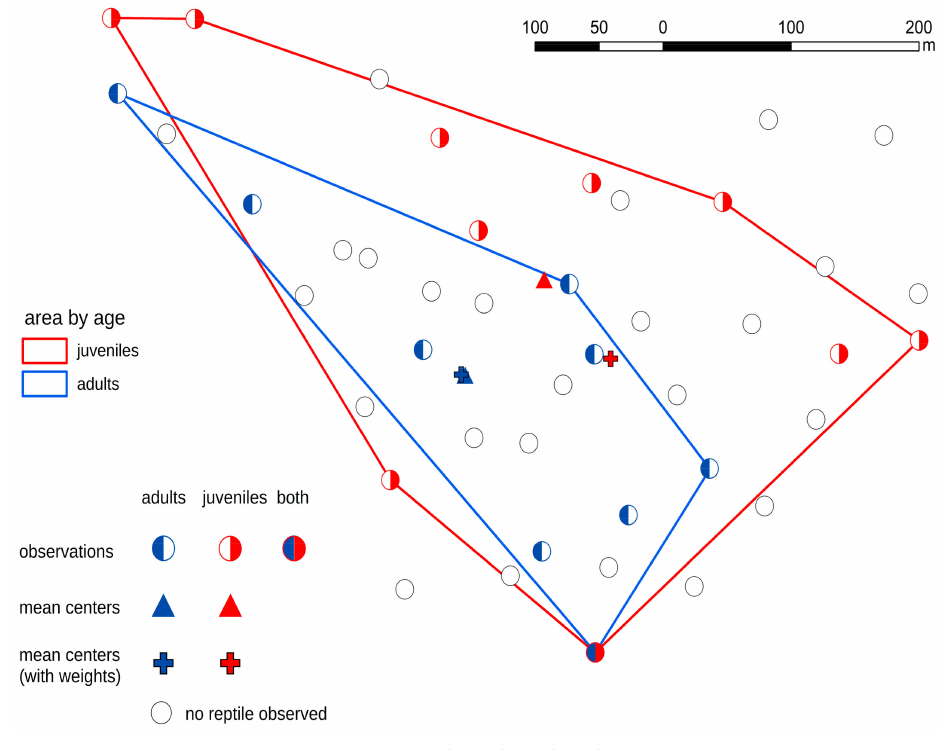
Figure 3. Smooth snakes’ distribution.